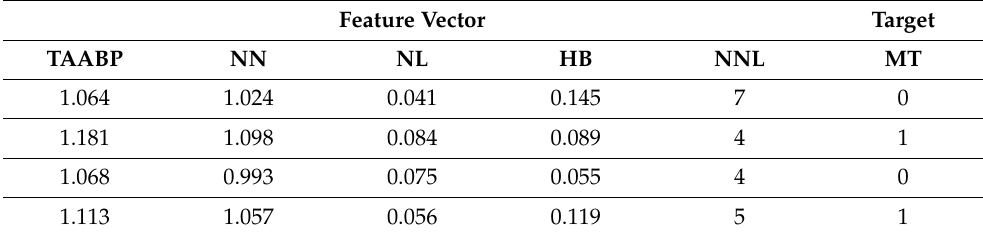
Table 3. Data obtained by simulating random samples from a Bayesian